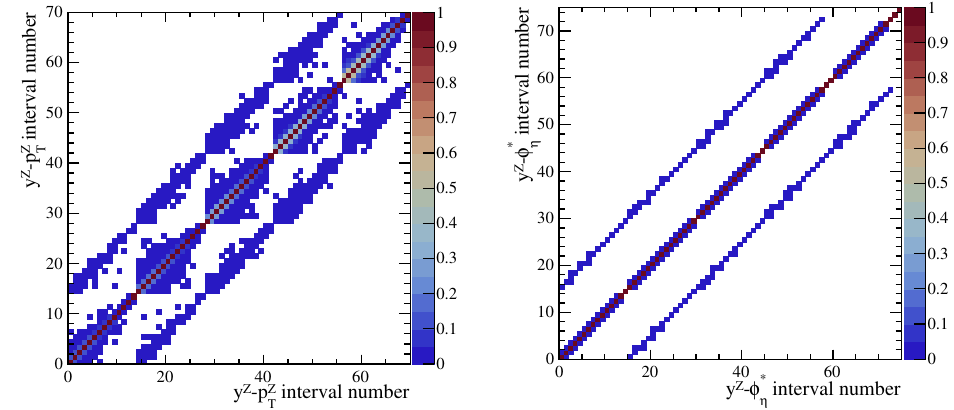
Figure 13 . Statistical correlation matrix of the cross-section measurements in two-dimensional interval regions of (left) y Z − p Z and (right) y Z − φ ∗ . More details about the ‘interval number’ can η T be found in table 17 and table